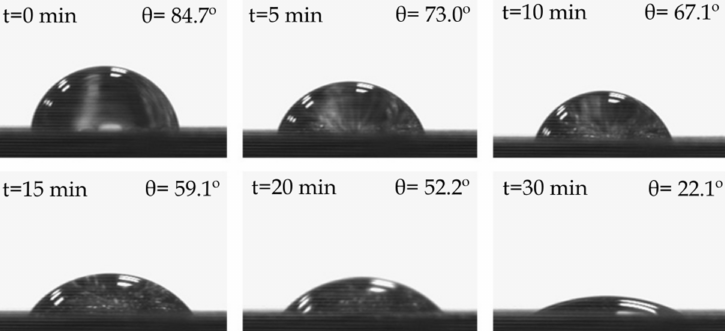
Figure 9. Water contact angle of the sample Bio-HDPE/PE-g-MA/MAS/MLO over time: 0, 5, 10, 15, 20, and 30